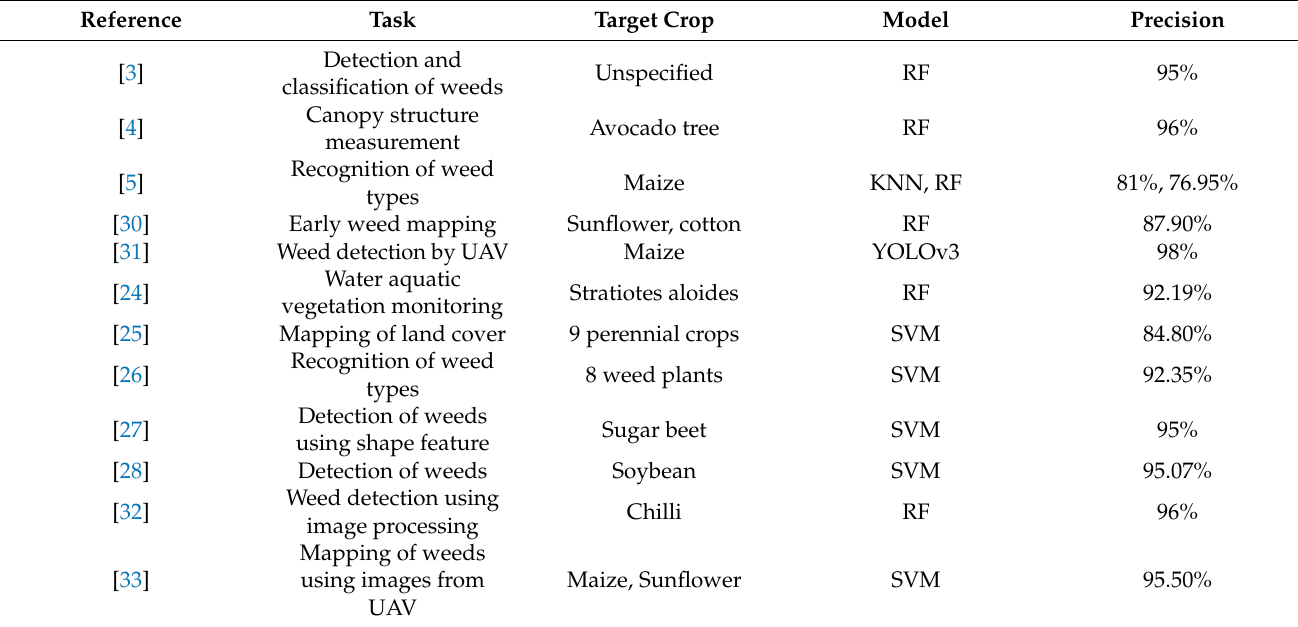
Table 1. Weed detection approaches published in the